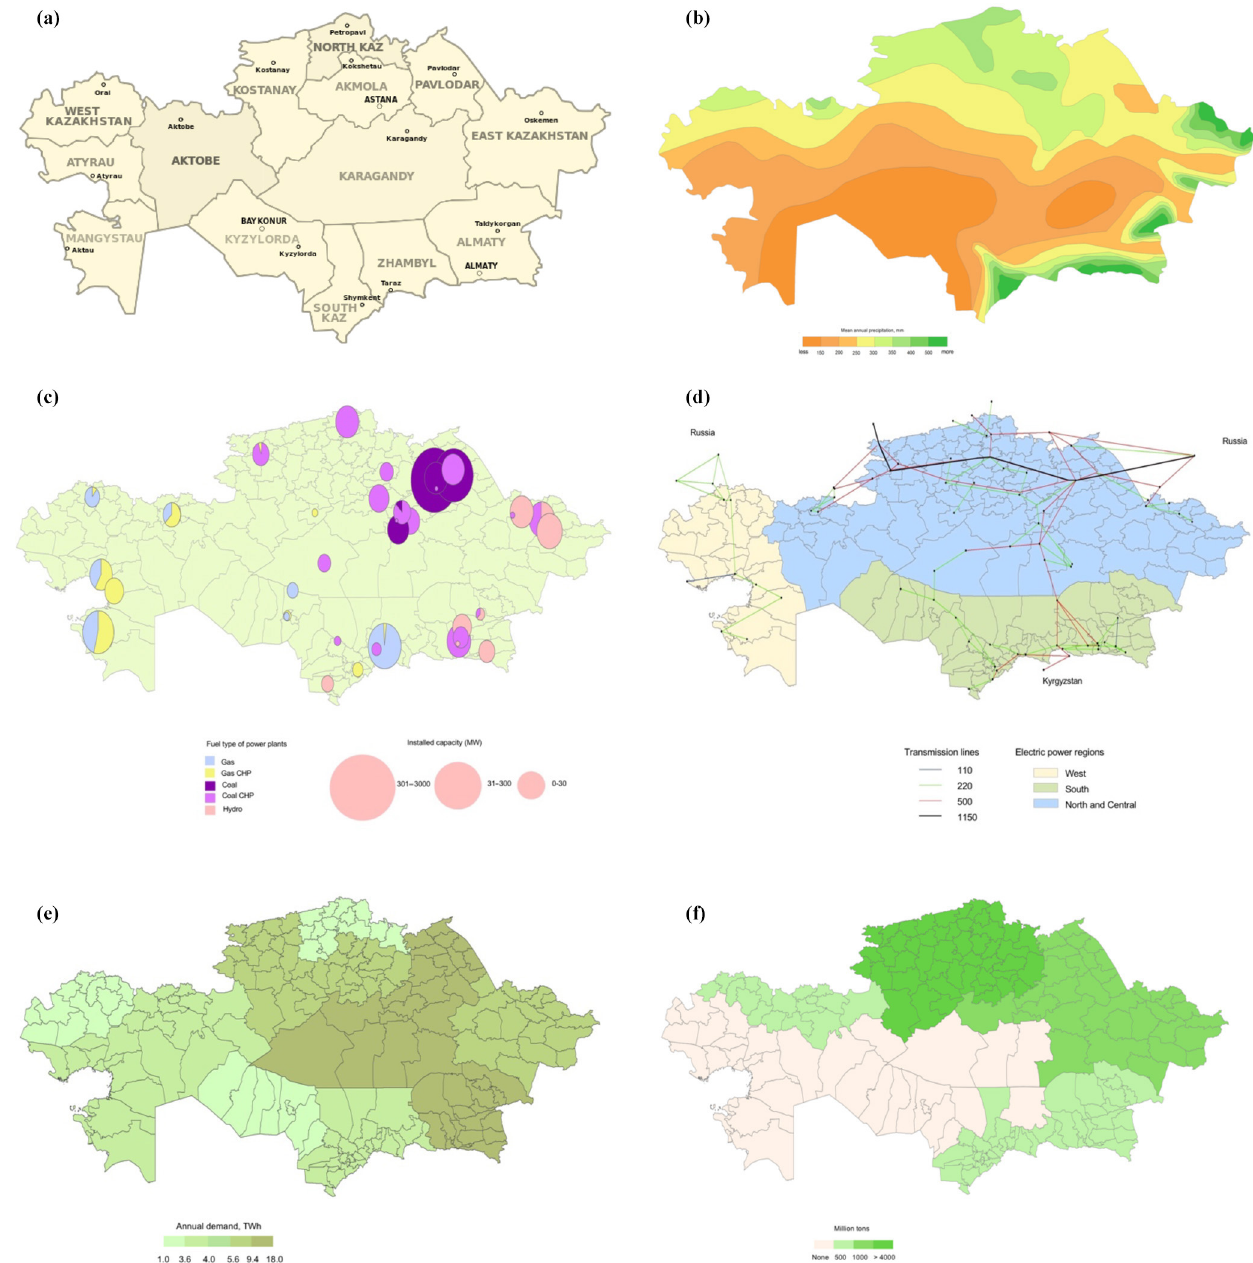
Figure 1. (a) Administrative provinces of Kazakhstan; (b) mean annual precipitation; (c) electricity capacity generation by fuel type; (d) elec- tric power zones; (e) annual energy demand by regions; (f) major areas of wheat